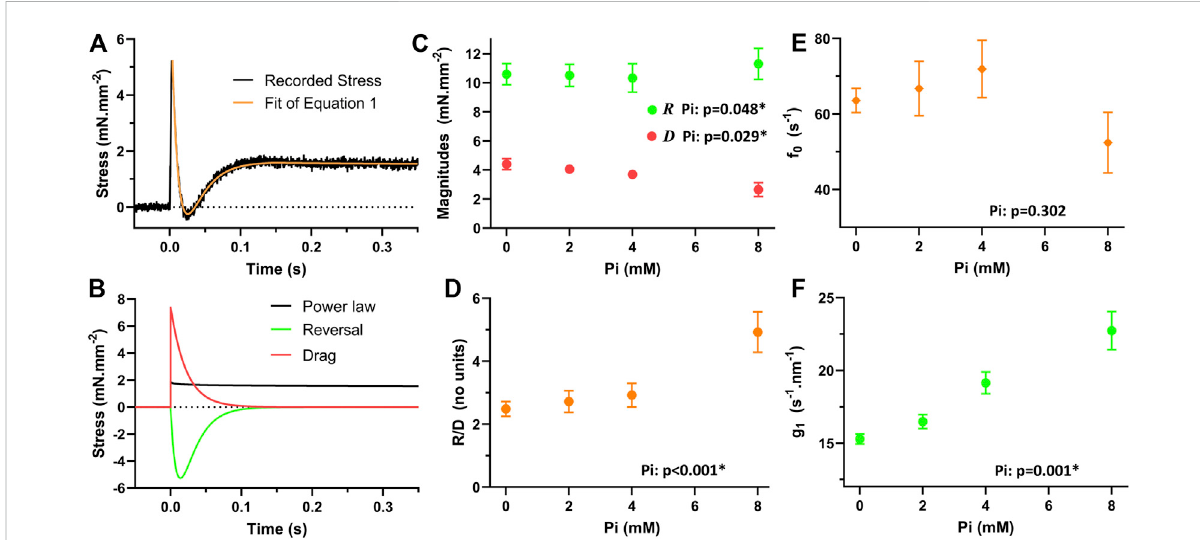
FIGURE 7 Modeled response of myo fi laments to quick stretch. (A) Eq. 1was fi tto themyo fi lament response to aquick stretch. (B) The three termsof Eq. 1 demonstratehoweach term contributes to theresponse. Power-law relaxation term constitutes the resultant “ stretch activated ” stress. The reversal term is responsible for the transient drop in the stress. The drag term constitutes the initial brief rise in stress after the stretch. (C) The magnitudes of the reversal and drag terms were sensitive to Pi. The magnitude of reversal, R , was signi fi cantly enhanced with increasing Pi, p < 0.05. The magnitude of drag, D , was signi fi cantly reduced with increasing Pi, p < 0.05. (D) The ratio of R/D was signi fi cantly enhanced with increasing Pi, p < 0.01. (E) AccordingtoEq.1,theattachmentrate, f 0 ,canbedeterminedbysubtractingthek redev ,equivalentto g 0 inthemodel,fromk rel